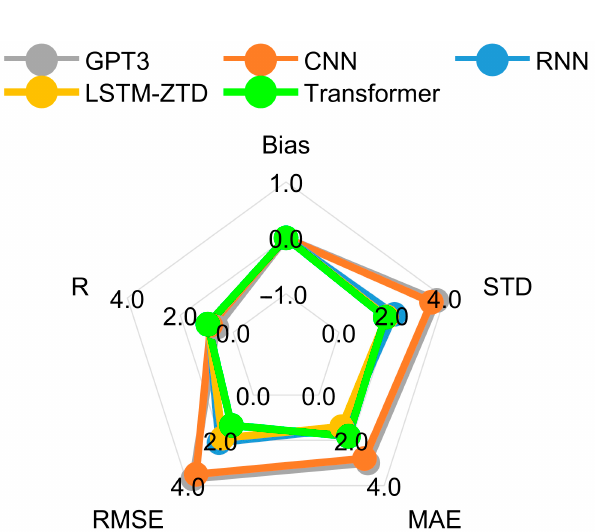
Figure 11. Transformer accuracy radar. Gray, orange, blue, yellow, and green represent GPT3, CNN, RNN, LSTM, and transformer models, respectively. Table 2. Transformer accuracy indicators (cm) and time spent.